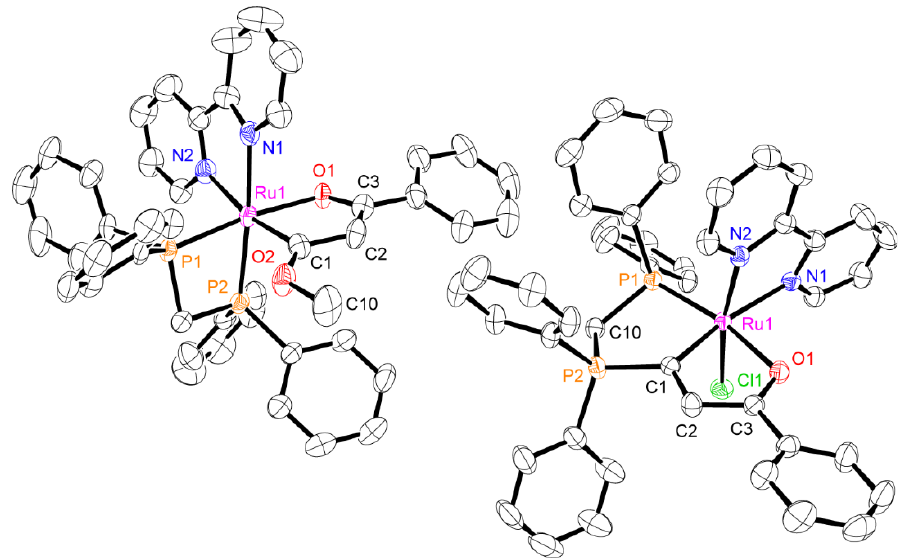
Figure 2. Perspective views of [ 4 ] + (left) and [ 5 ] + (right) as represented by 50% probability ellipsoids (hydrogen atoms are omitted for clarity). Selected bond lengths (Å ) and angles (°): [4] + : Ru1−C1